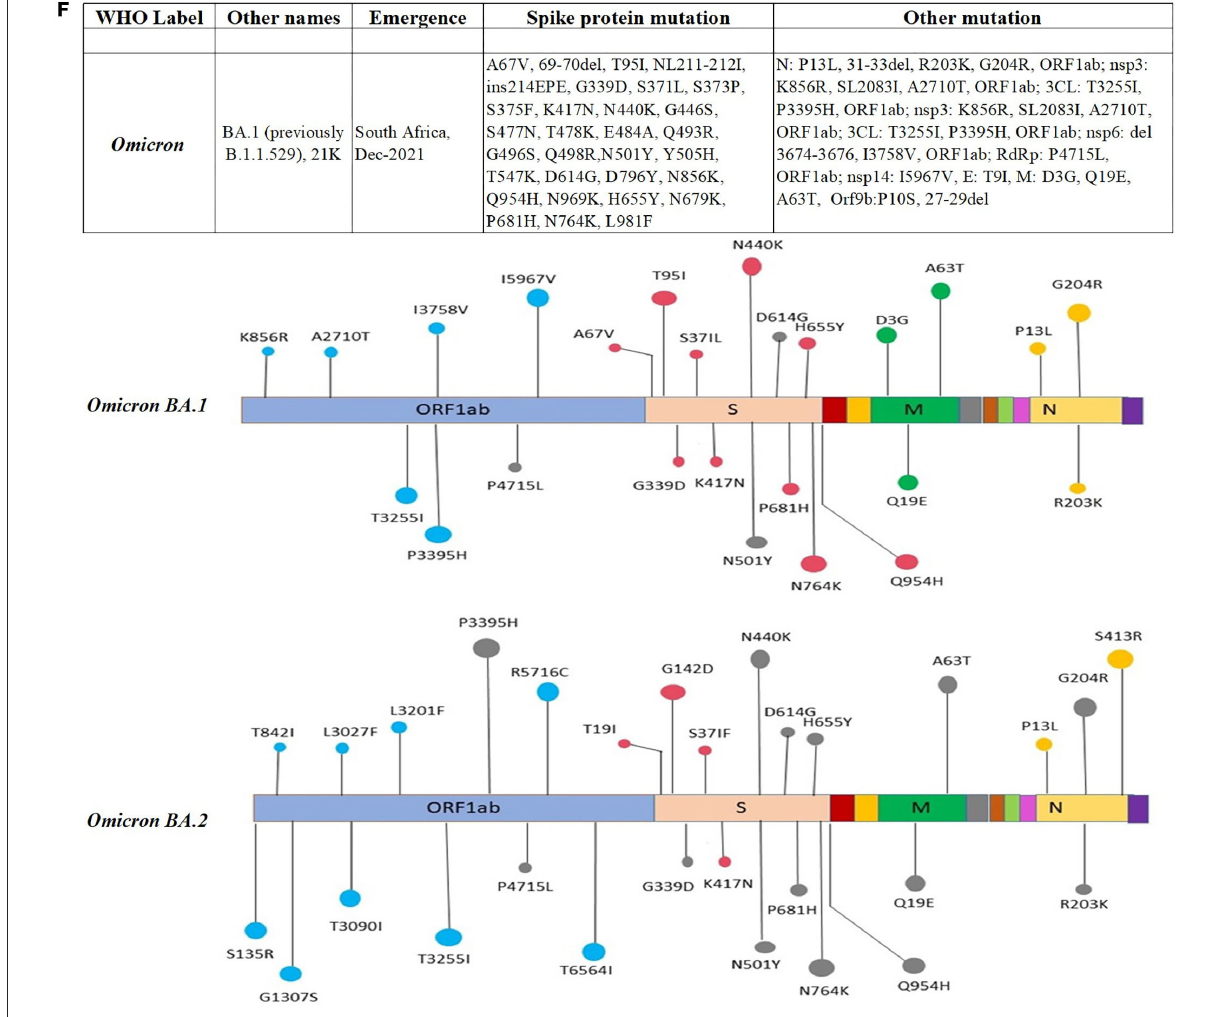
Alpha variant, (C) showing mutations in the genome of the Beta variant, (D) showing mutations in the genome of the Gamma variant. (E) Location of mutations reported in various regions of the Delta and Delta-plus SARS-CoV-2 variant. The ORFs of the SARS-CoV-2 genome are represented with different colors and the mutation present on the ORF is indicated on the respective ORFs. (F) Location of mutations reported in various regions of the Omicron BA.1 and BA.2 SARS-CoV-2 variant. The ORFs of the SARS-CoV-2 genome are represented with different colors and the mutation present on the ORF is indicated on the respective